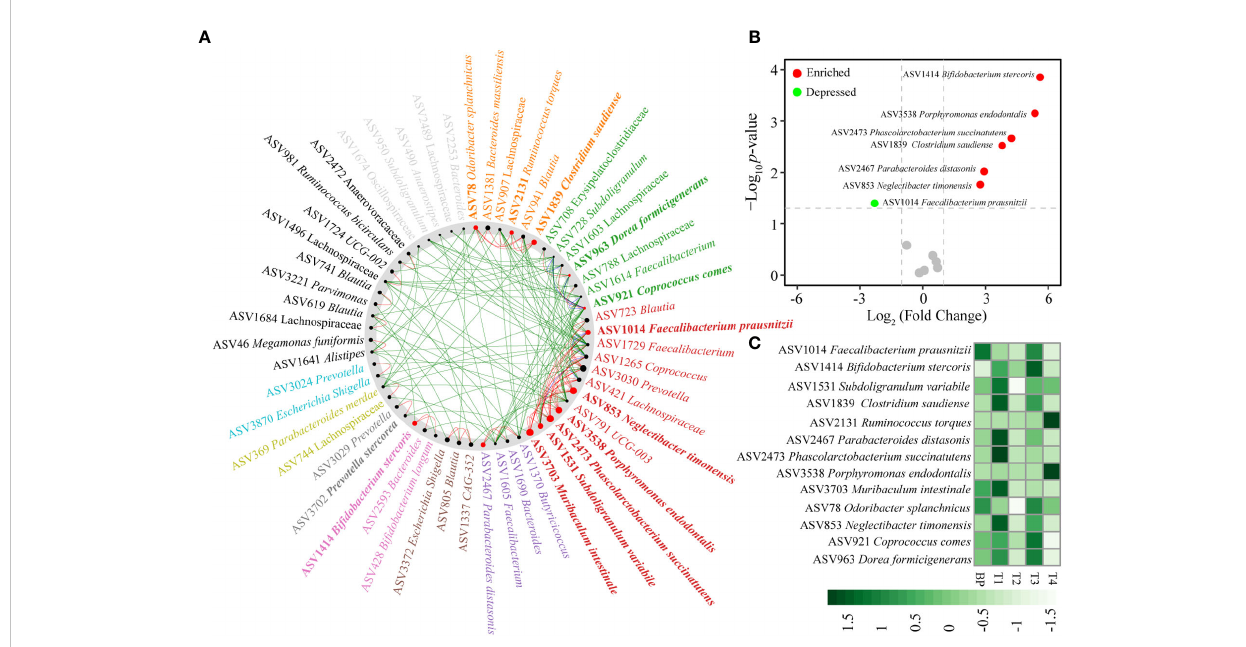
FIGURE 4 Identi fi cation of “ driver ” taxa from benign BP to CRC T1 tumor (A) , changes between T1 and BP (B) , distributions in BP and along the four CRC stages (C) . The nodes of the common sub-network were placed around a circle that was sorted by their identi fi ed community membership (in the CRC T1 network). All nodes belonging to the same community are assigned similar colors. Black nodes represent nodes that exist in both but interact directly with the common sub-network in either T1 tumor or BP. The size of the node is proportional to the NESH fraction of its scale, and the node is colored red if the intermediation of the node increases from BP to T1 tumor status. Thus, large red nodes are particularly important “ driver ” taxa. Refer to Figure 1 for